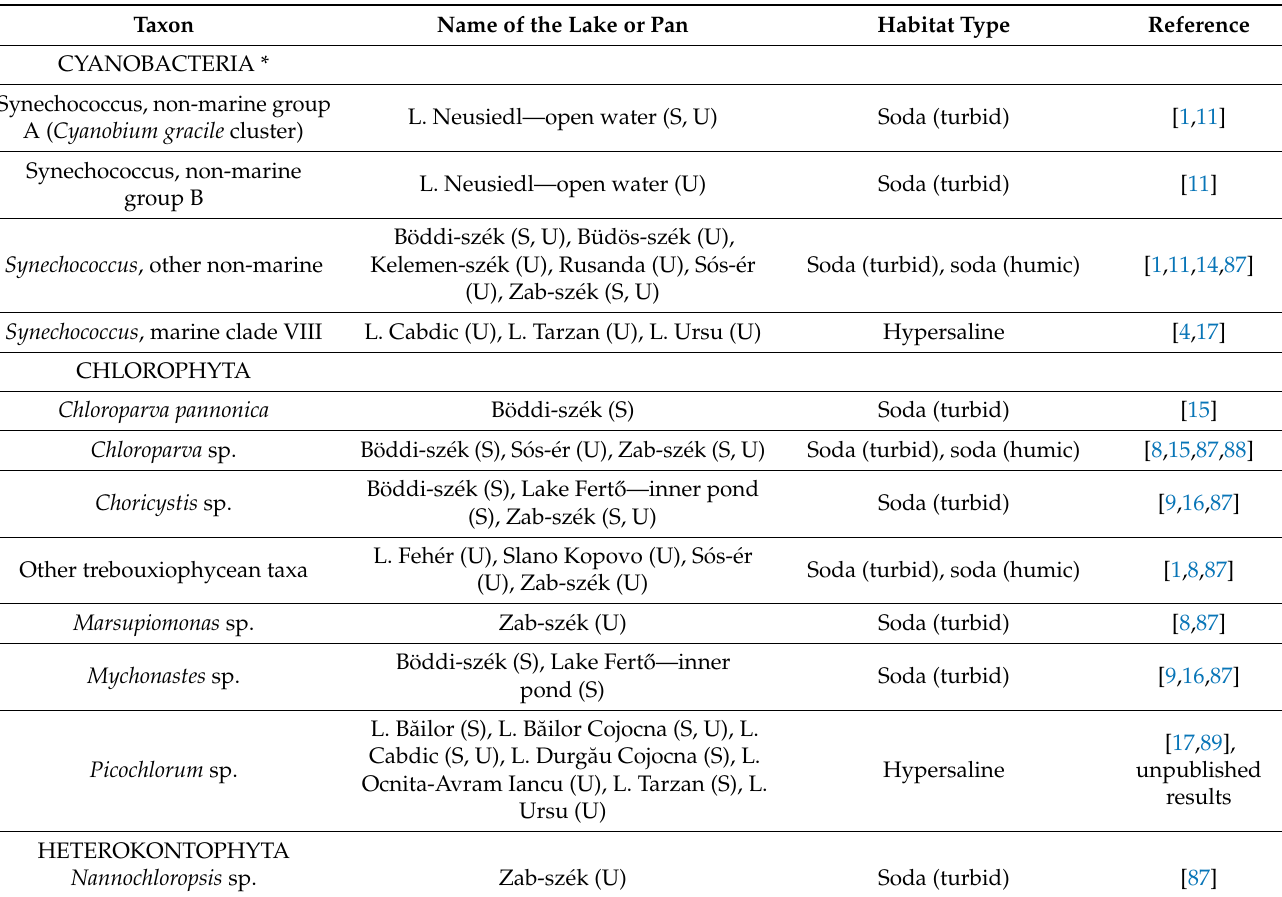
Table 3. List of APP taxa detected in the soda and saline lakes of the Carpathian